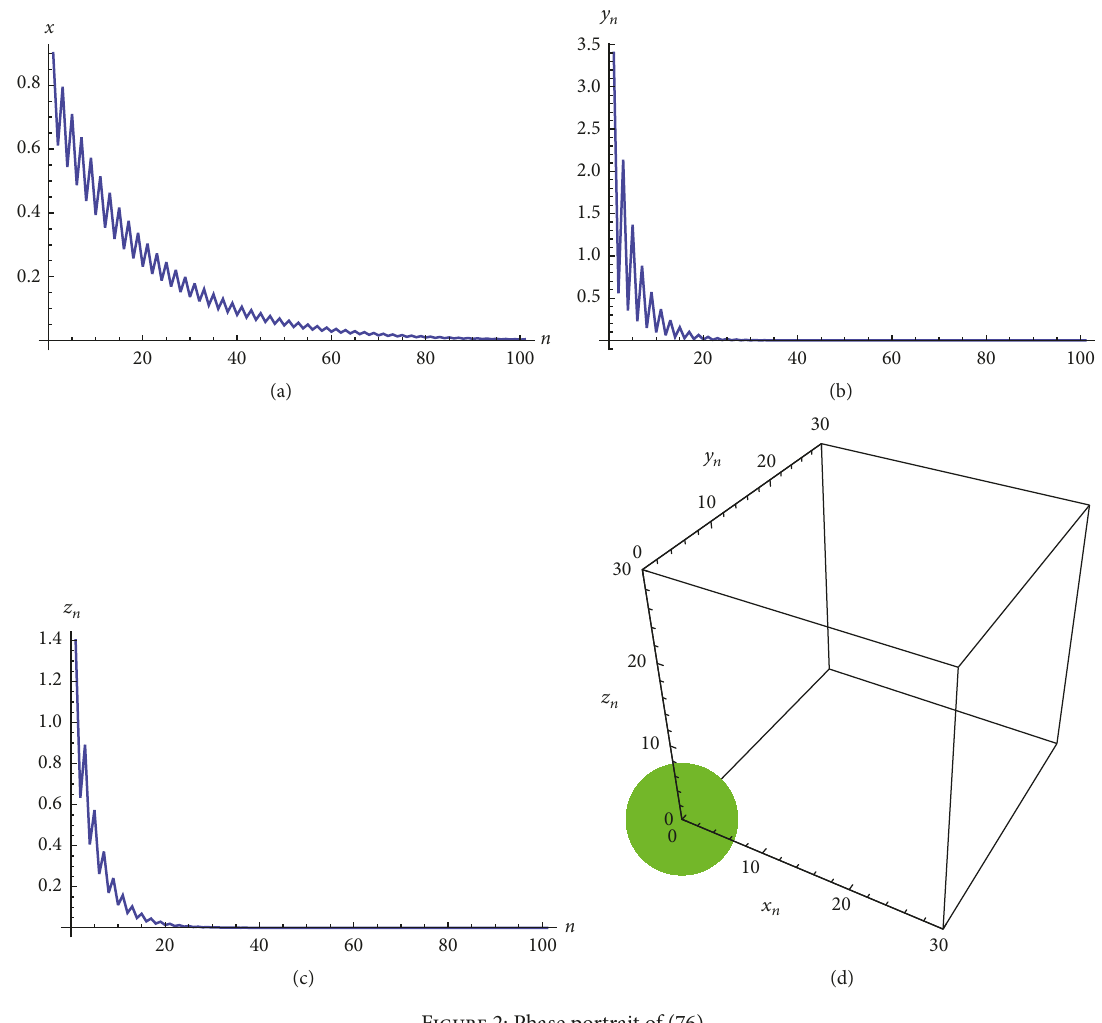
Figure 2: Phase portrait of (76).